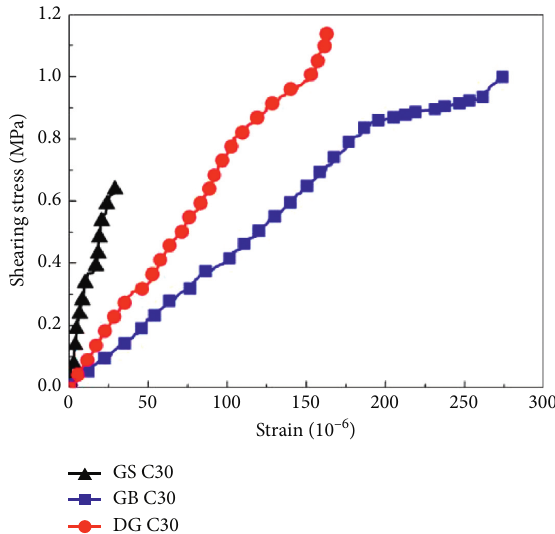
Figure 5: Stress-strain curves of the interface for composite samples with different cement plates.